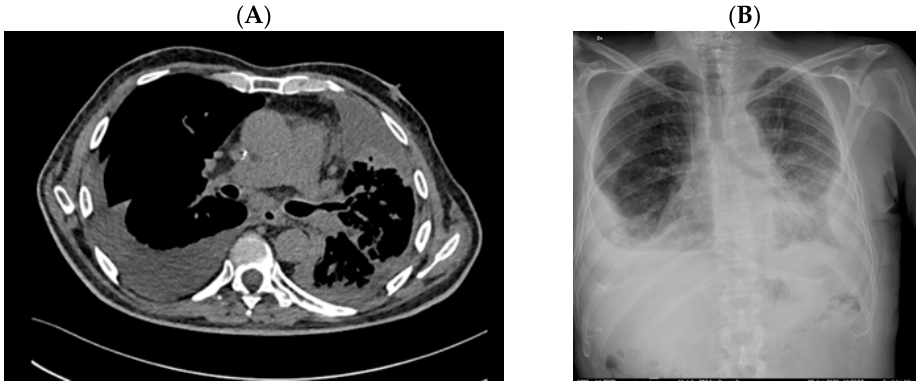
Figure 4. September 2021. ( A,B ) Computer Tomography and X-ray highlighting simultaneous reduction of bilateral pleural effusion and carcinomatous lymphangitis.